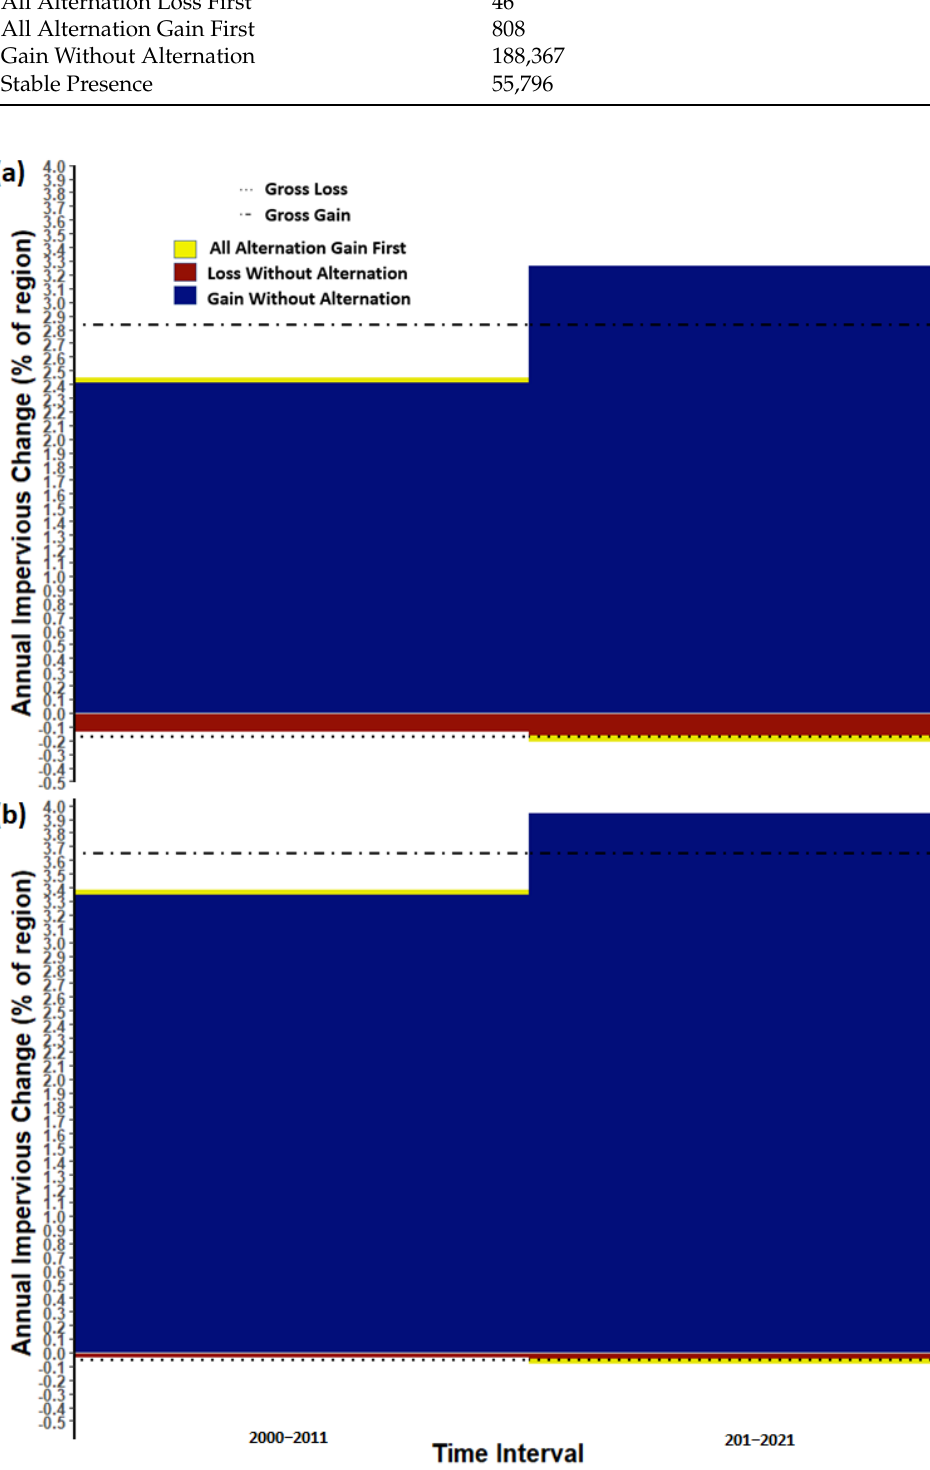
Figure 6. Stacked bars of the trajectories of UIS change in ( a ) Accra and ( b ) Kumasi during two time intervals: 2000 − 2011, and 2011 − 2021. The % of the region is the uni fi ed region.